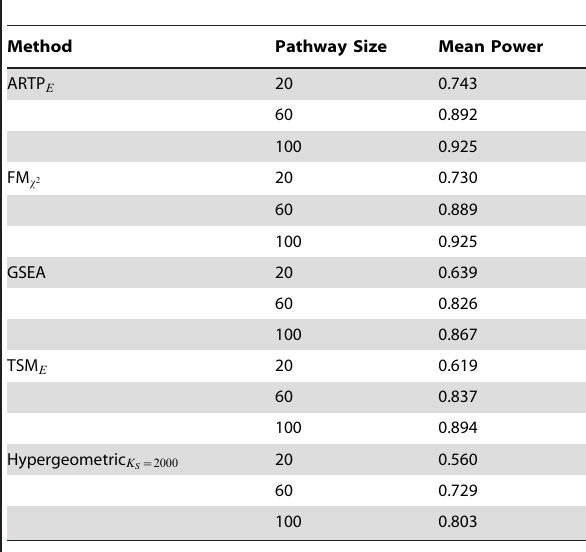
Table 2. Mean power of the methods for the different pathway